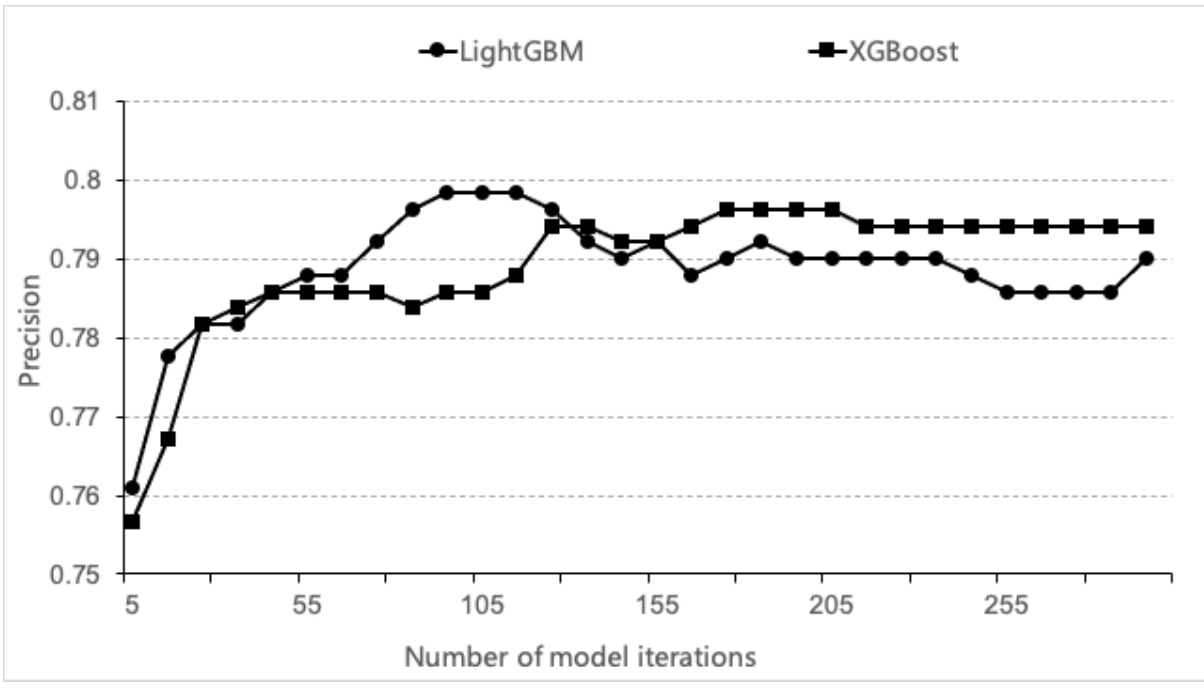
Figure 5. Performance based on the LightGBM and XGBoost algorithms. The abscissa represents the number of model iterations, and the ordinate shows the precision of the